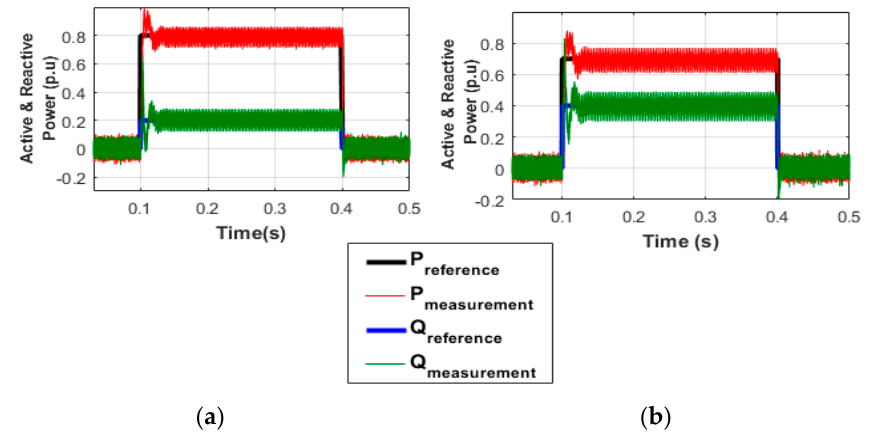
Figure 13. Different step changes in the active and reactive power reference. ( a ) Step change of 0.8 p.u in active and 0.2 p.u in reactive power; ( b ) Step change of 0.7 p.u in active and 0.4 p.u in reactive power.